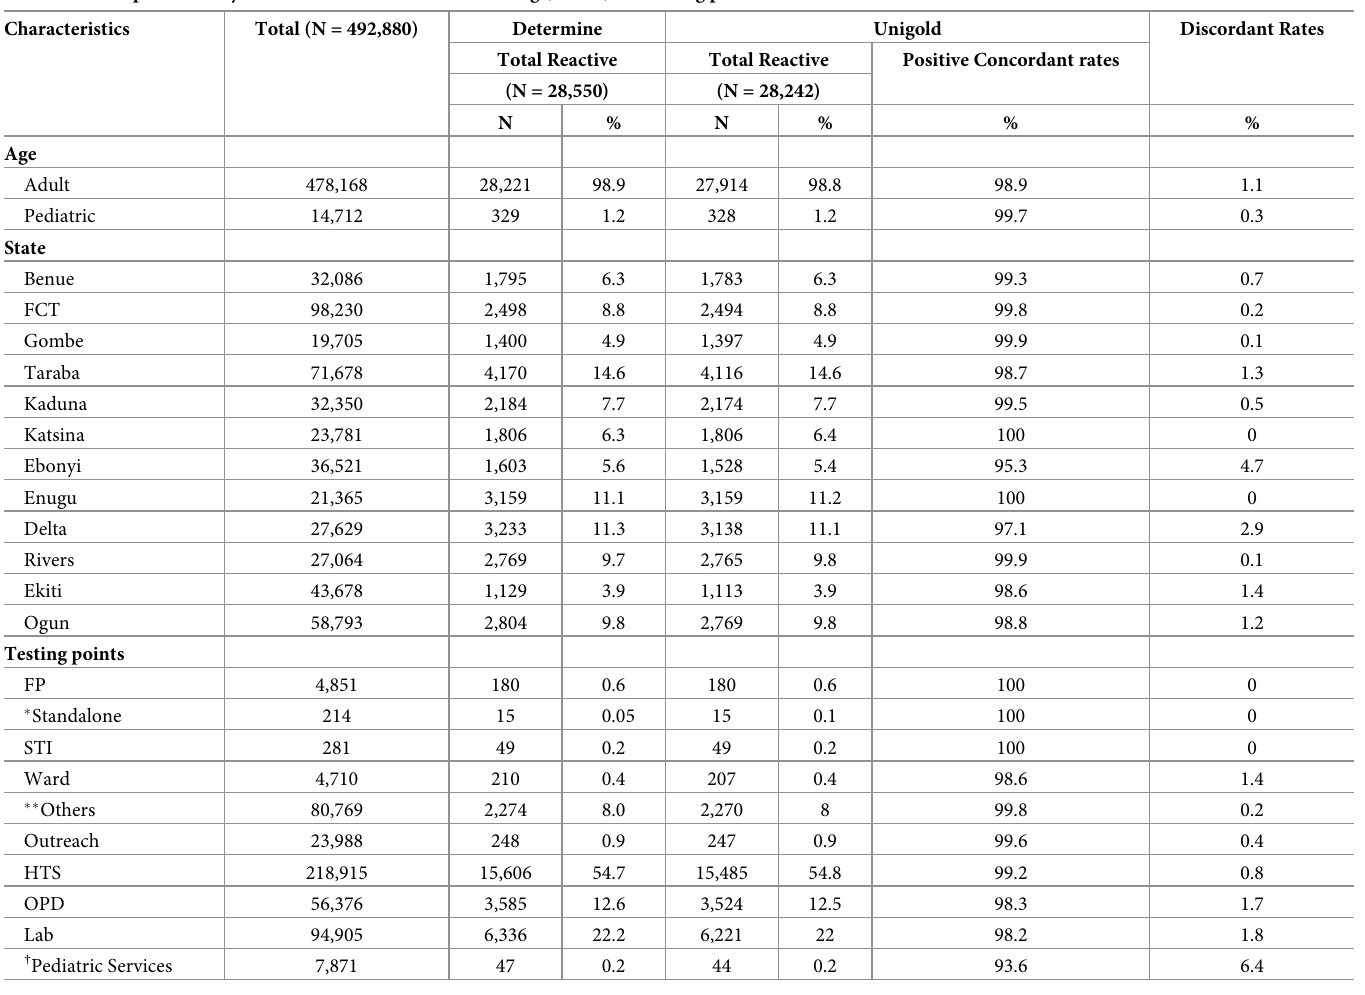
Table 2. Retrospective analysis of the discordance rates across age, states, and testing points.